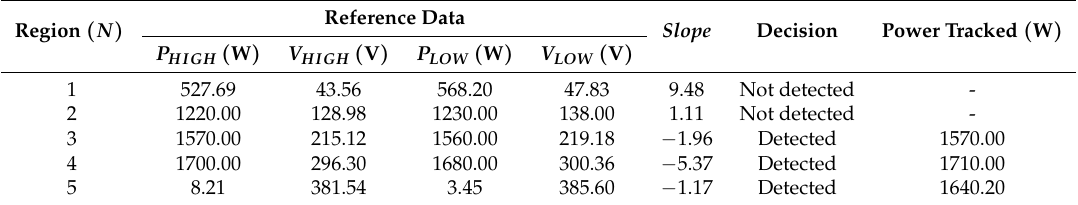
Table 3. Summarized result for Global MPPT using slope calculation of pattern C and